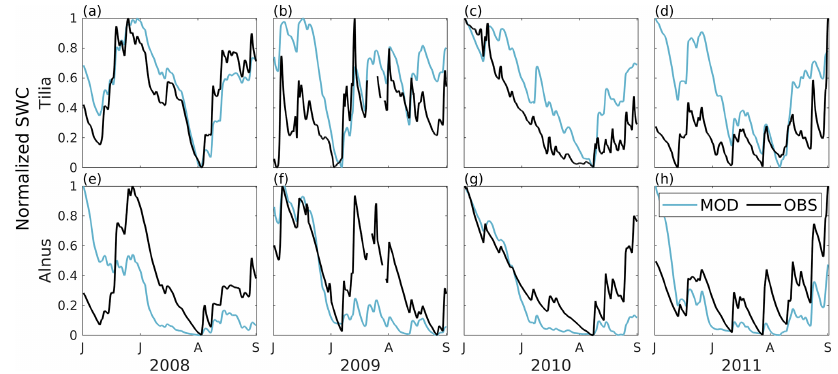
Figure 3. Modelled (MOD, blue) and observed (OBS, black) 1d running mean of normalized soil water content (SWC) from June to August in 2008–2011. The normalization uses minimum and maximum values of modelled and observed SWC, respectively. The normalization is performed separately for each year. Table 4. SUEWS model performance statistics for soil water content (SWC), transpiration, and the CO 2 exchange components at the Tilia and Alnus